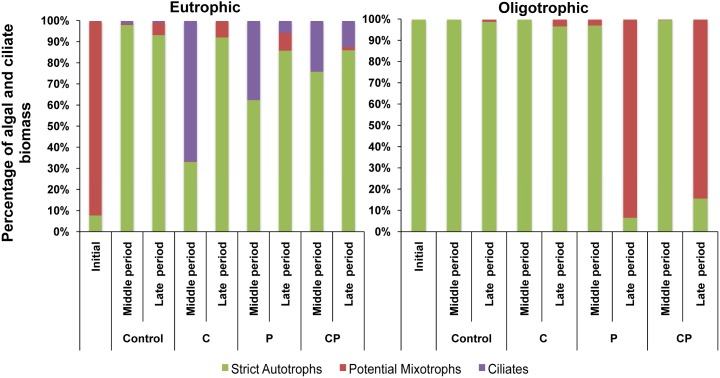
Experimental dynamics of algal and ciliate biomass in the two ecosystems.(A) eutrophic ecosystem; (B) oligotrophic ecosystem. Columns represent the percentage of mean biomass values of the different planktonic functional groups (strict autotrophs, potential mixotrophs and ciliate) over the experiment.